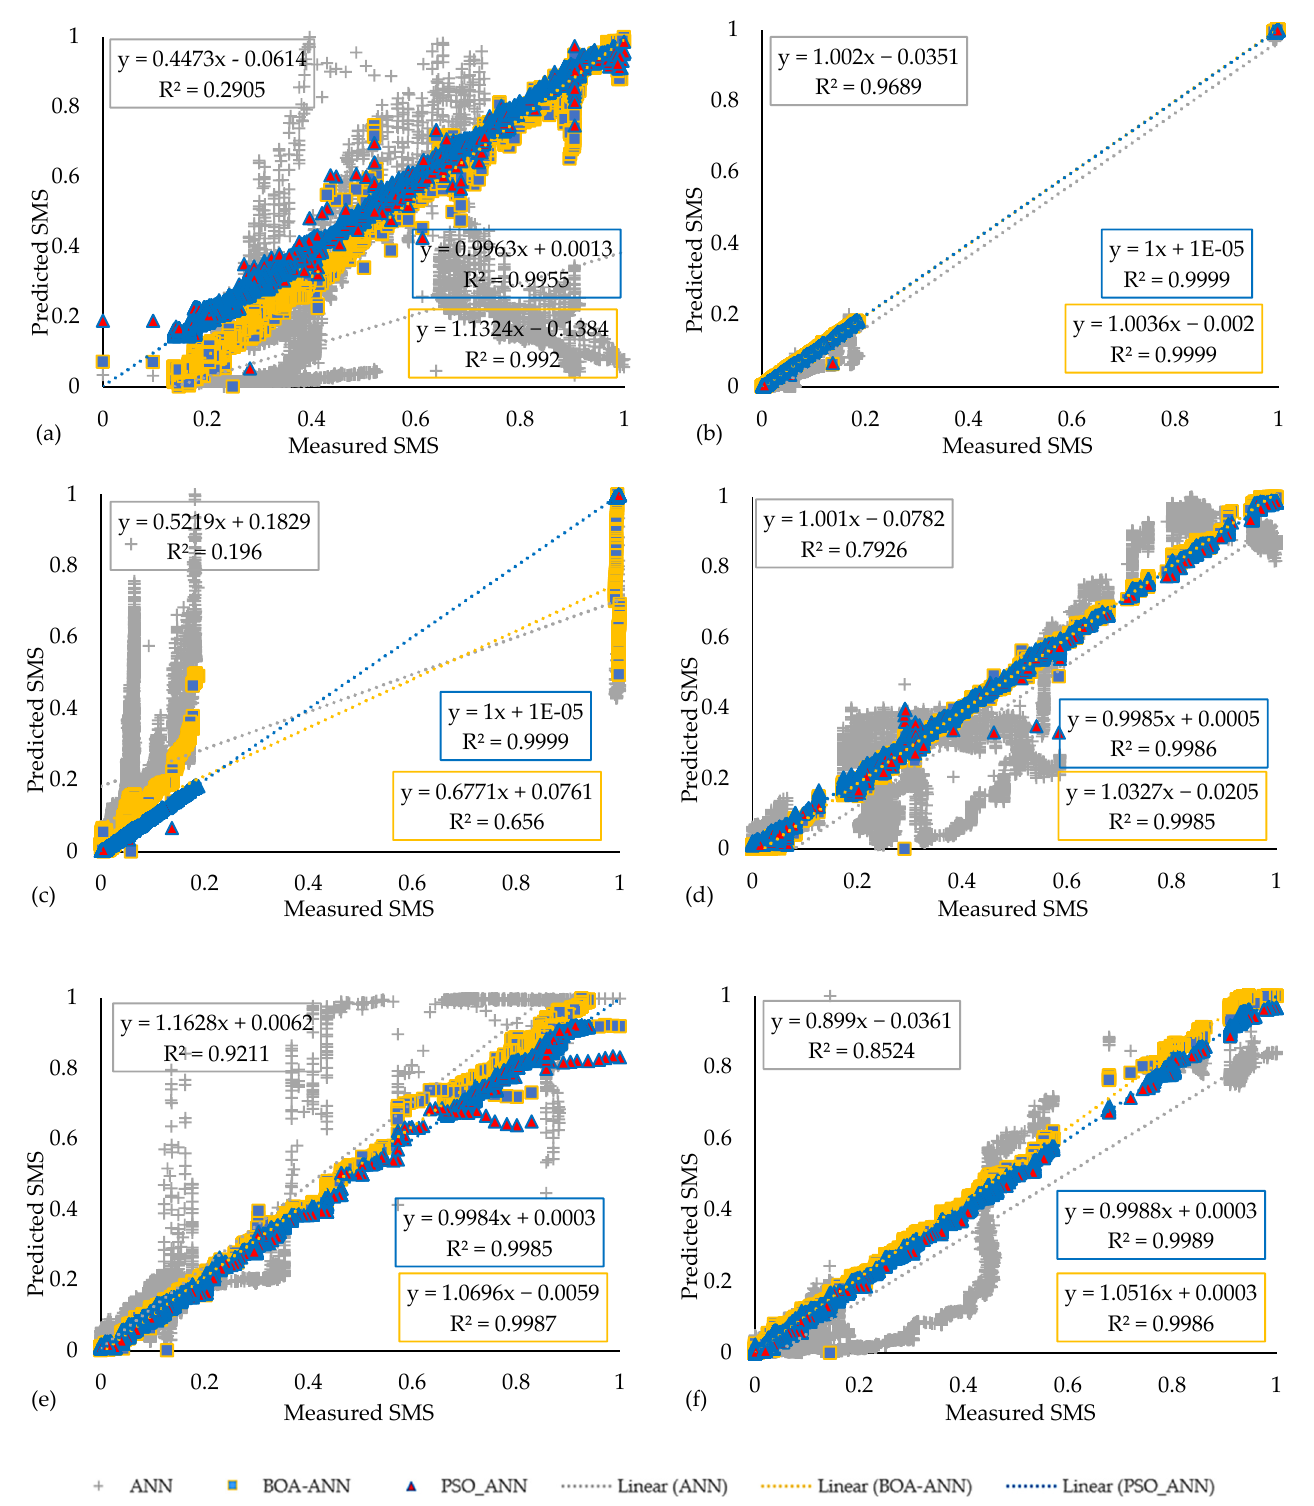
Figure A3. Predicted vs. measured SMS at 3 m depth overtime via ANN-BR, PSO-ANN, and BOA-